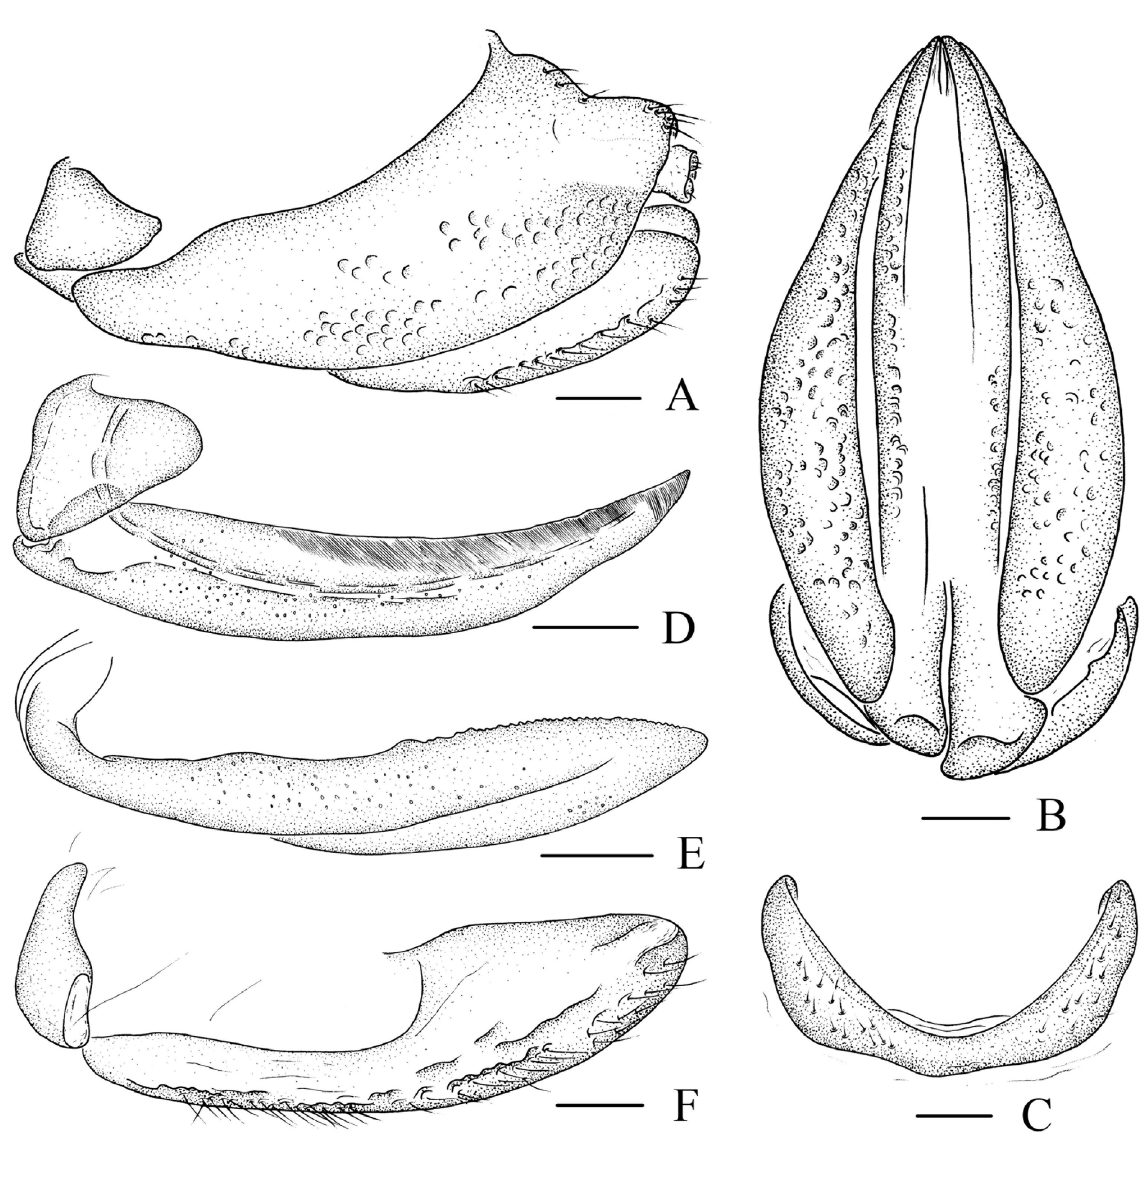
Fig. 4. Machaerotypus stigmosus Li & Chen sp. nov., paratype, ♀ (IEGU). A–B . Genitalia in lateral and ventral view. C . Sternite VII, ventral view. D . First valvulae, lateral view. E . Second valvulae, lateral view. F . Third valvulae (gonoplac), lateral view. Scale bars = 0.2